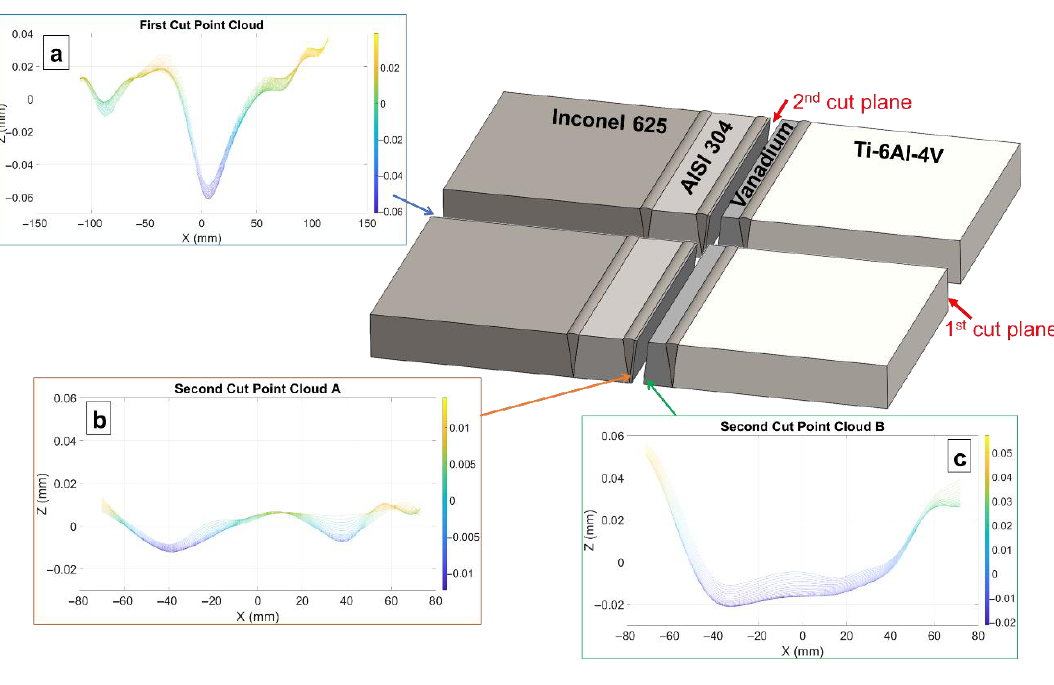
Figure 6. Surface profile of ( a ) the first cut, ( b ) the second cut side A (Inconel 625 side), and ( c ) the second cut side B (Ti6Al4V side), after cubic spline smoothing.